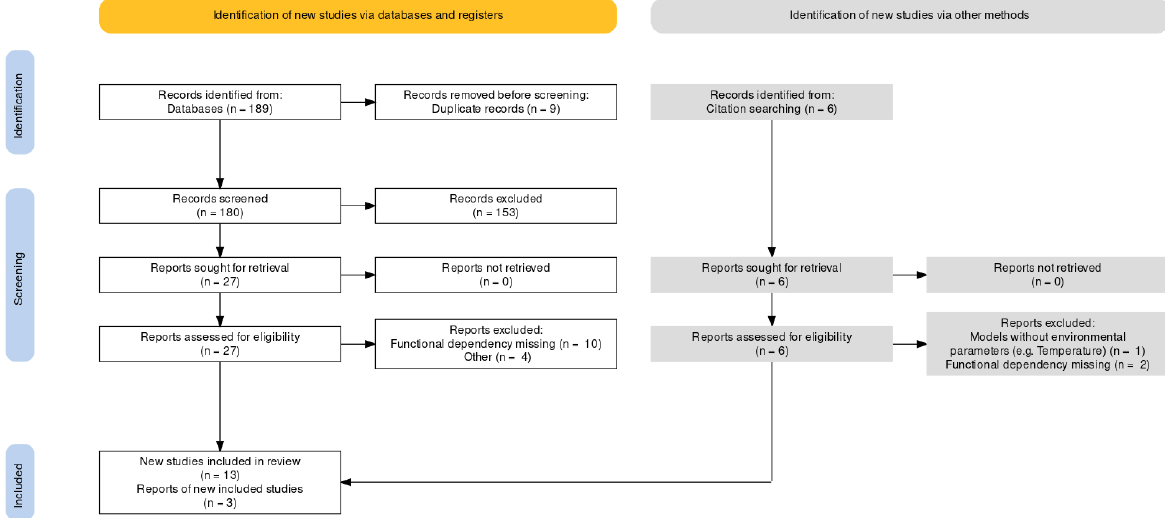
Figure A1. PRISMA flow chart for the literature retrieval and